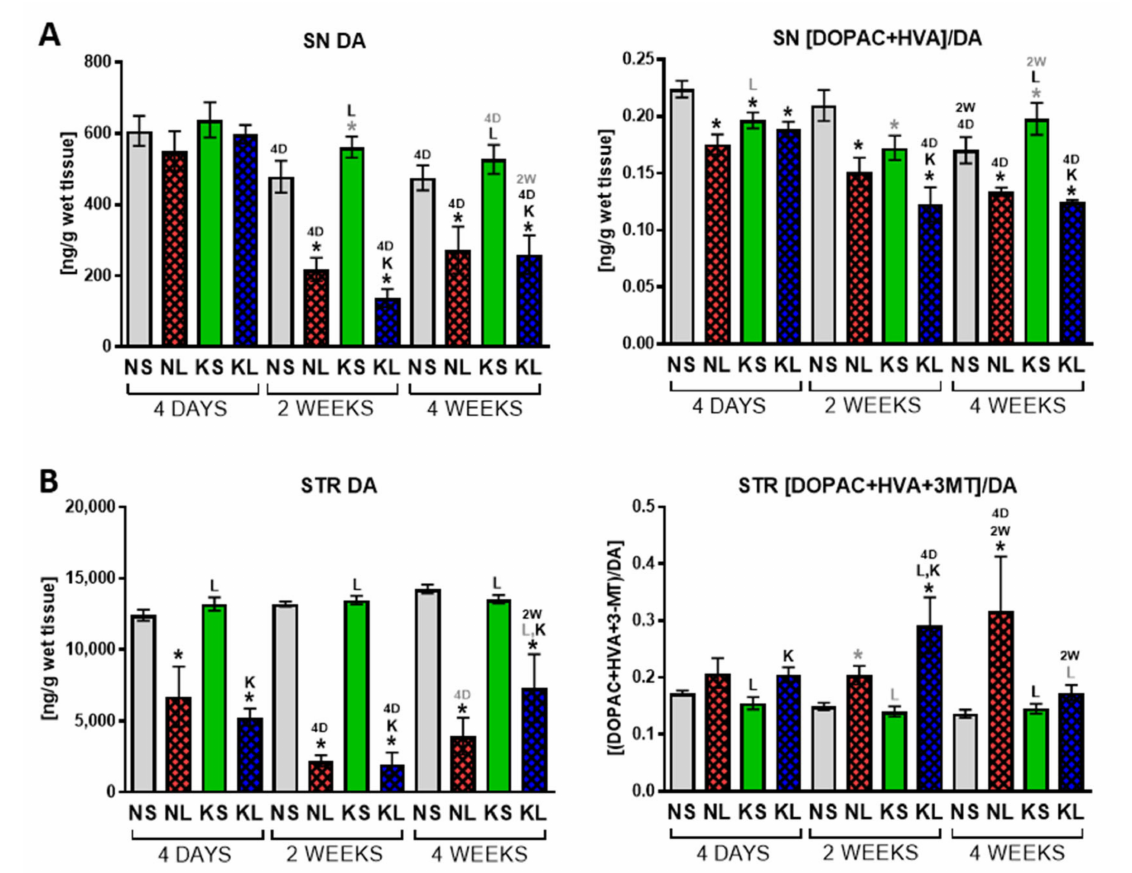
Figure 4. HPLC analysis of DA and its turnover rate in dopaminergic structures SN ( A ) and STR ( B ). Turnover rate was calculated as sum of measured metabolites to neurotransmitter ratio. Data are presented as mean ± SEM. Analysis was performed at time-points 4 days, 2 weeks, and 4 weeks after brain surgery. Animals were kept on ketogenic diet for 3 weeks in advance. p value ≤ 0.05 was set as significance threshold and marked as * vs. normal diet + sham (NS group), L vs. normal diet + 6-OHDA lesion (NL group), K vs. ketogenic diet + sham (KS group), KL stands for ketogenic diet + 6-OHDA lesion group, 2W vs. 2 week time-point, 4D vs. 4 day time-point. Statistical trends 0.05 < p ≤ 0.1 were marked in grey symbols. Statistics: 3-way ANOVA with LSD post hoc test. Number of animals was 5–7 per